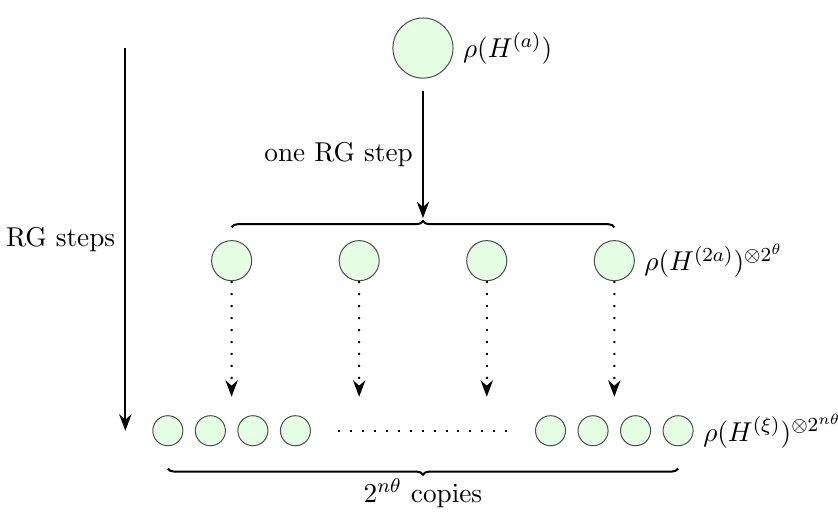
Figure 4. An illustration of a branching tensor network with (cid:18) = 2 ; s = 4. The circles at each layer represent copies of the thermal density matrix of the corresponding Hamiltonian. After (cid:16) (cid:17) (cid:24) n = log RG steps, we get 2 n(cid:18) copies of the density matrices (cid:26) ( H ( (cid:24) ) ), corresponding to 2 a